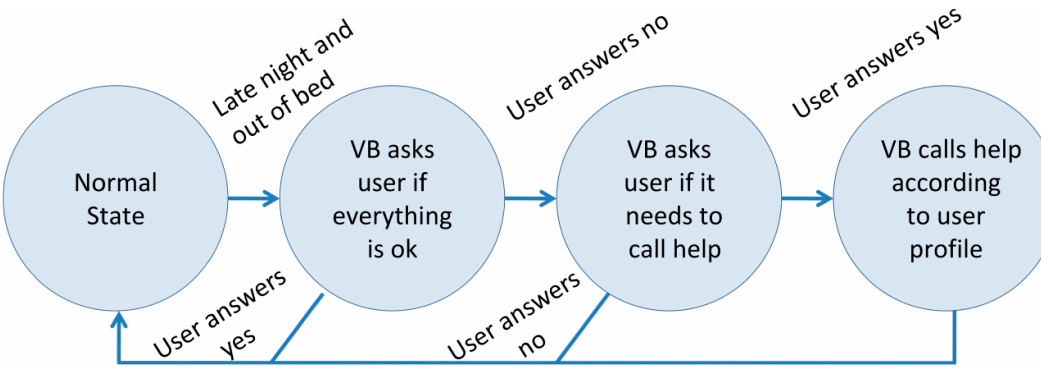
Figure 11. Algorithm used by Virtual Butler to handle abnormal